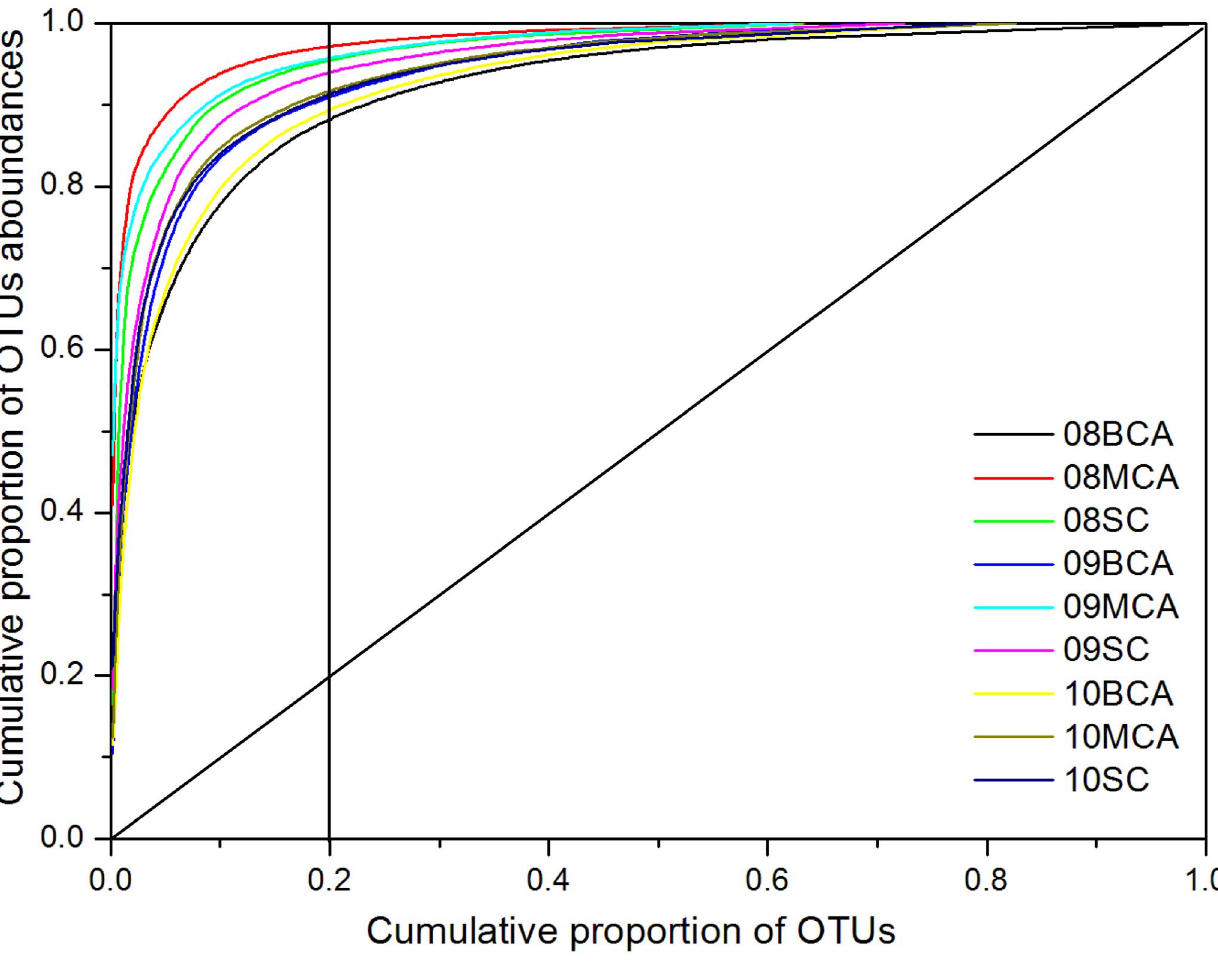
Figure 2. Pareto-Lorenz curves derived from phycosphere samples in Lake Taihu. The 16S rRNA gene sequences were divided in OTUs based on a sequence similarity threshold of 97% and the OTUs were ranked from high to low, based on their abundance. The Pareto-Lorenz evenness curve is the plot of the cumulative proportion of OTU abundance (y-axis) against the cumulative proportion of OTUs (x-axis). The Fo index, i.e. the combined relative abundance of 20% of the OTUs, is shown. The 45 u diagonal is the Pareto-Lorenz curve of a community with perfect